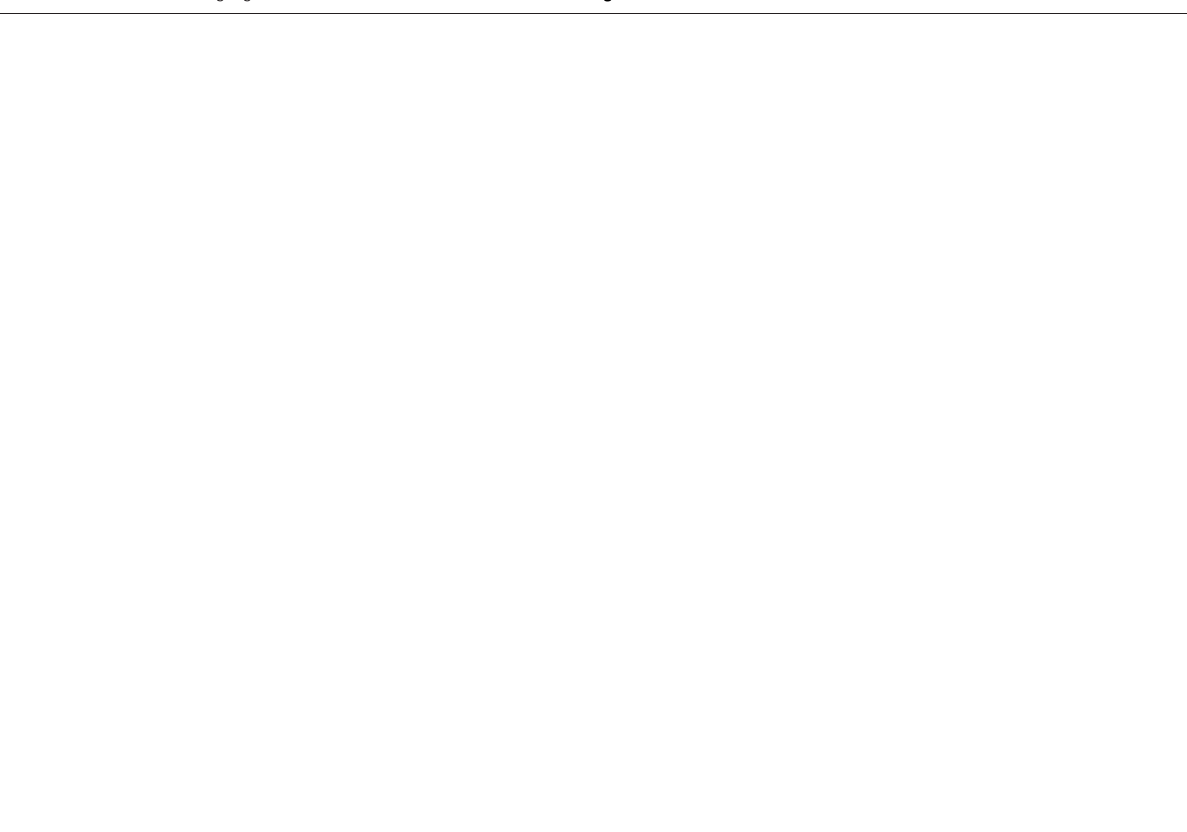
FIGURE A2 | Time course of BOLD responses for selected ROIs in Table 2 in the main text. BOLD time courses are shown for those six ROIs in Table 2 (color-highlighted in Table 2 ) that